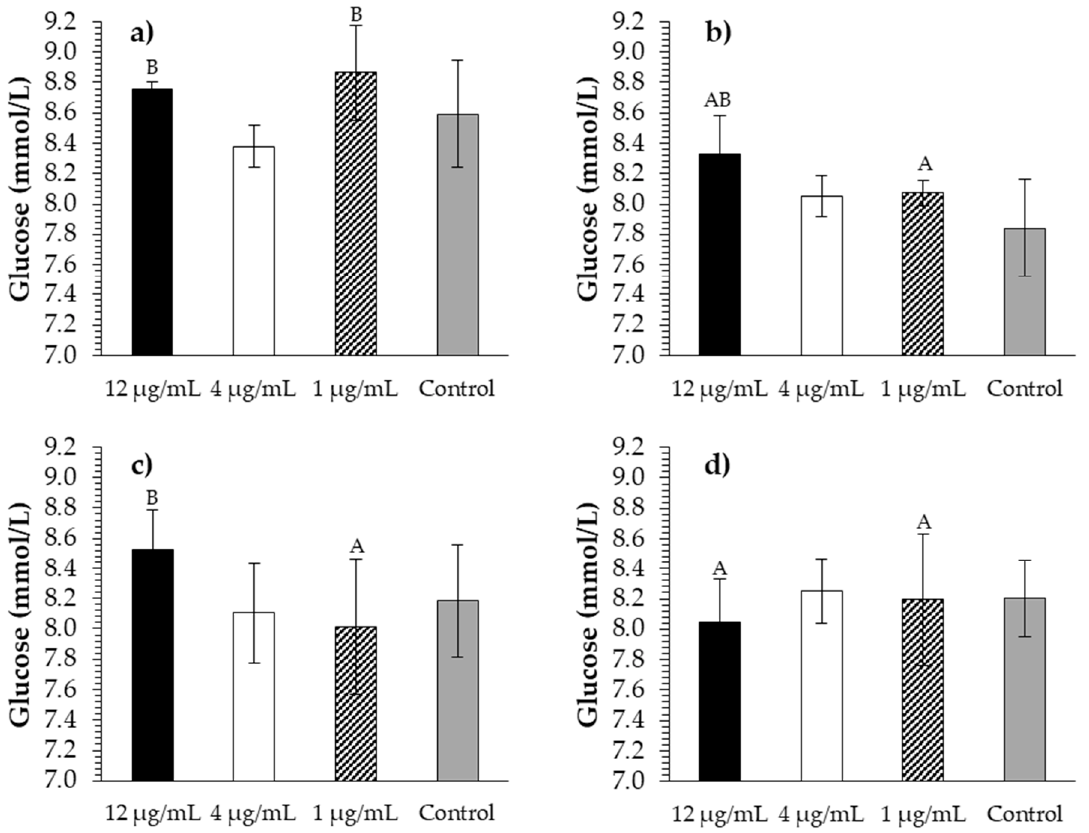
Figure 3. Glucose bioavailability and transport through CLAB cells. ( a ) Tanex; ( b ) Farmatan; ( c ) Contan; ( d ) gallic acid. Results presented as mean glucose concentration of independent triplicates ± standard deviations. Capital letters represent statistically significant differences between HT tannins at p ≤ 0.05.